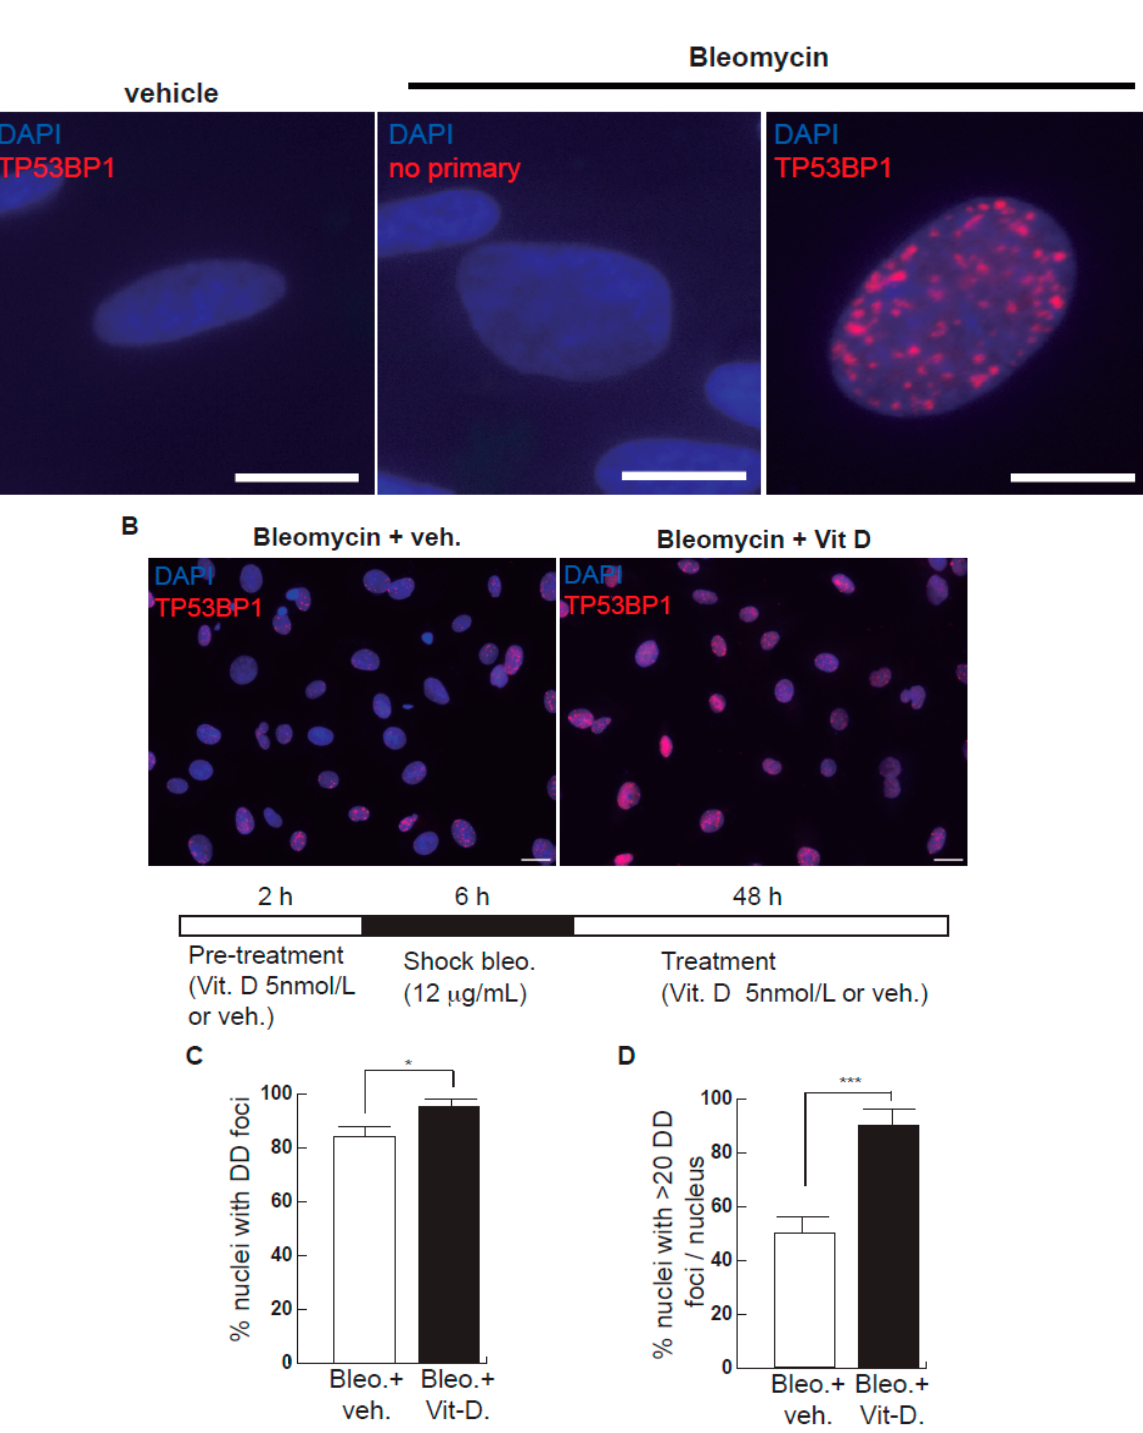
Figure 1. Effects of bleomycin and vitamin D in A549 cells. ( A ) A549 cells were treated with bleomycin with a sublethal bleomycin shock (12 μ g/mL for 6 h) incubated for 48 h and then processed for indirect immunofluorescence to detect DNA damage foci containing TP53BP1 (red dots), a reliable marker of DNA double-strand breaks (DSBs). Veh.: bleomycin vehicle (PBS). No